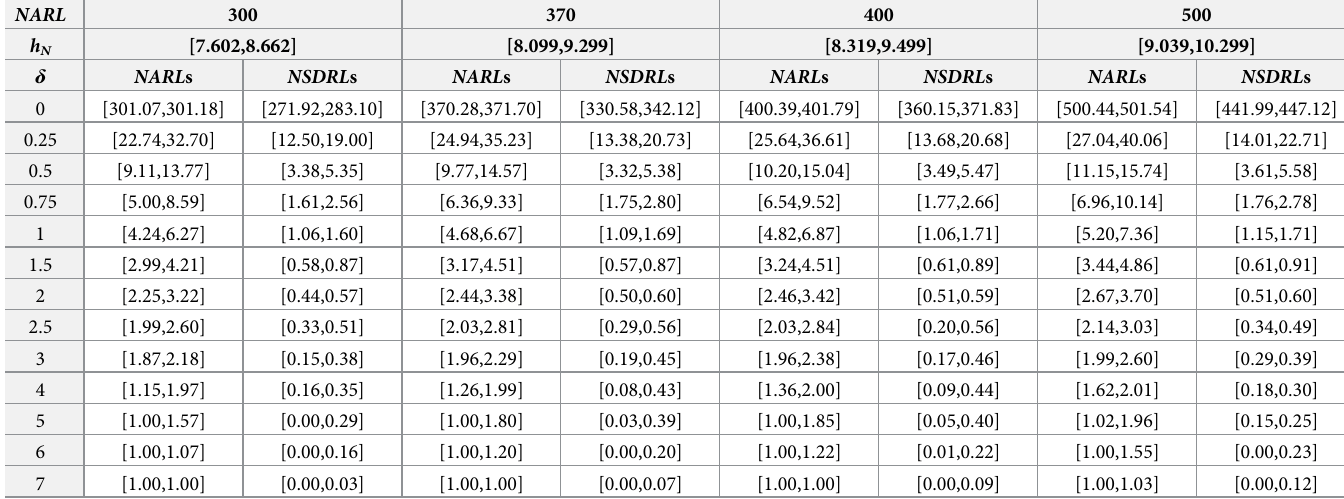
Table 1. The NARL and NSDRL values of the proposed NCUSUM � X chart when n N 2 [3, 5], k N 2 [0.20, 0.25] for different nominal NARL . NARL